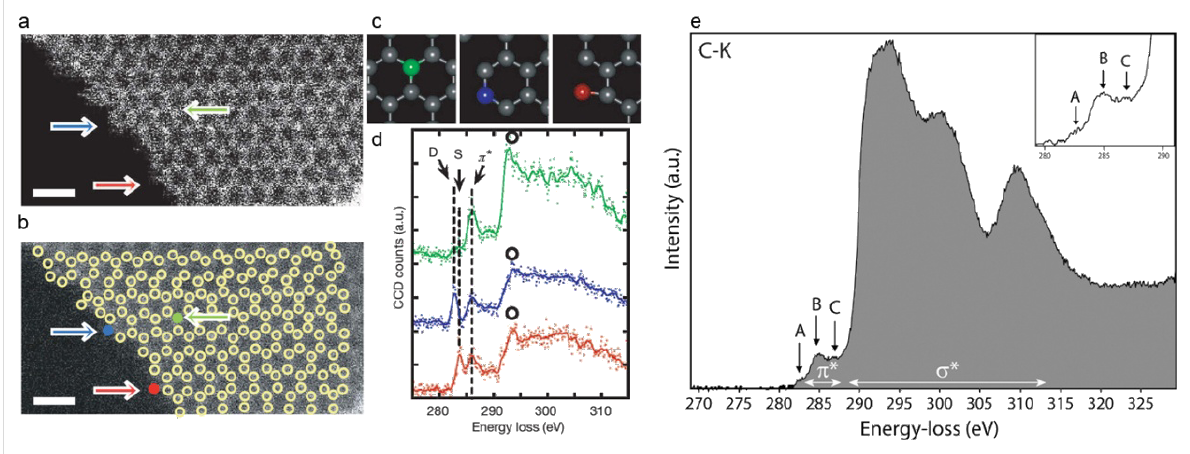
Figure 6: (a–d) Graphene edge spectroscopy; reproduced with permission from [29], Copyright (2010) Nature Publishing Group. (a) ADF-STEM image of a single graphene layer at the edge region. No image-processing has been done. Atomic positions are marked by circles in a smoothed image (b). Scale bars: 0.5 nm. (d) ELNES of carbon K1s spectra taken at the color-coded atoms indicated in (b). Green, blue and red spectra corres- pond to the normal sp 2 carbon atom, a double-coordinated atom and a single-coordinated atom, respectively. These different states of atomic coordi- nation are marked by colored arrows in (a) and (b) and illustrated in (c). (e) Experimental carbon K-edge ELNES acquired with monochromatic elec- tron illumination. The σ * feature starting at 290 eV is typical for diamond. The π * contribution around 285 eV consists of 3 pre-peaks, at 282.7 eV (A), 285 eV (B), and 286.6 eV (C); reproduced with permission from [93], Copyright (2013) John Wiley and